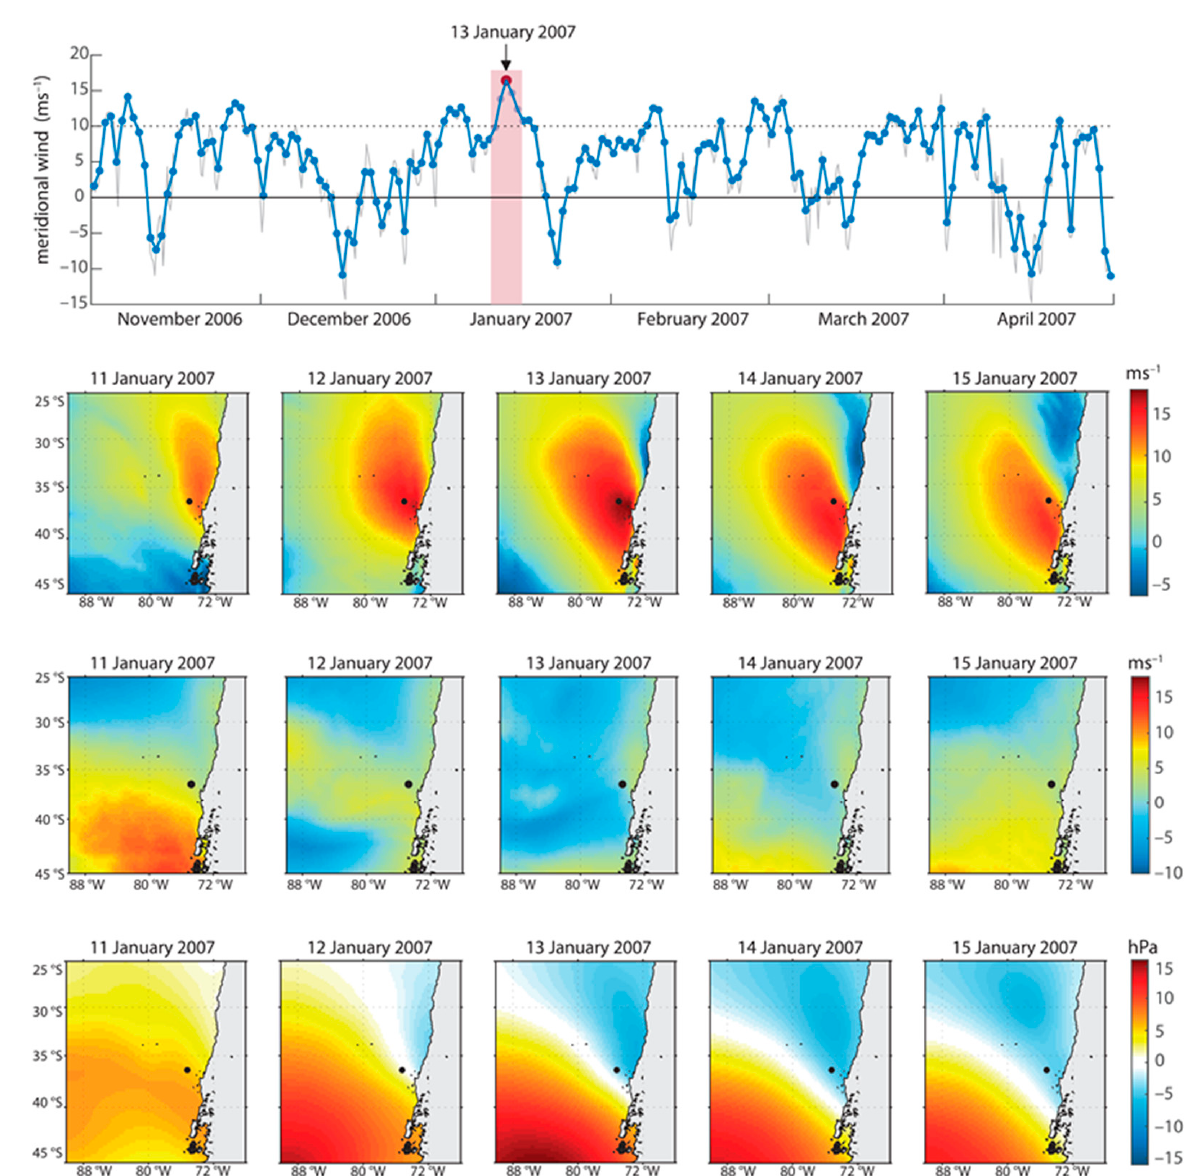
Figure 2. Daily mean time series of V a at 36 ◦ S for the period November 2006 to March 2007 ( upper panel ). Maps of V a (ms − 1 ) during the low-level coastal jet event observed between 11 to 15 January 2007 ( middle panels ). Maps of SLP anomalies (hPa) between 11 to 15 January 2007 ( bottom panels ).